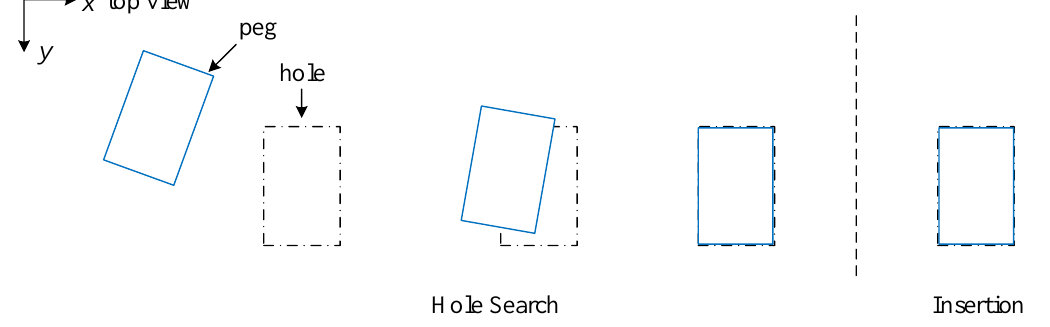
Figure 2. Peg-in-hole assembly